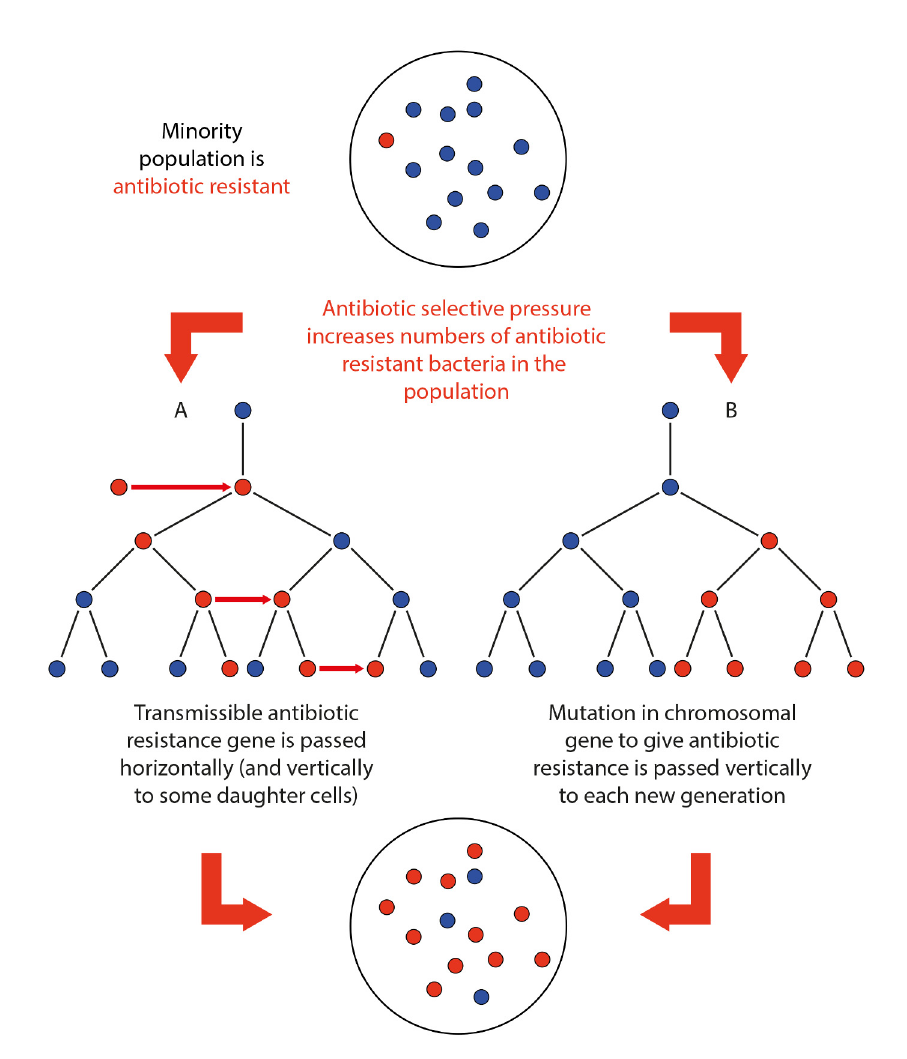
Fig 1. An illustration of how antibiotic resistance is selected in a bacterial population and how it proliferates. The large circle denotes an agar plate, test tube, human, animal, or other environment containing a population of bacteria. Small filled red circles, antibiotic-resistant bacterium. Small filled blue circles, antibiotic-susceptible bacterium. Red arrow denotes horizontal transmission between bacterial cells, black arrow indicates vertical transmission to daughter